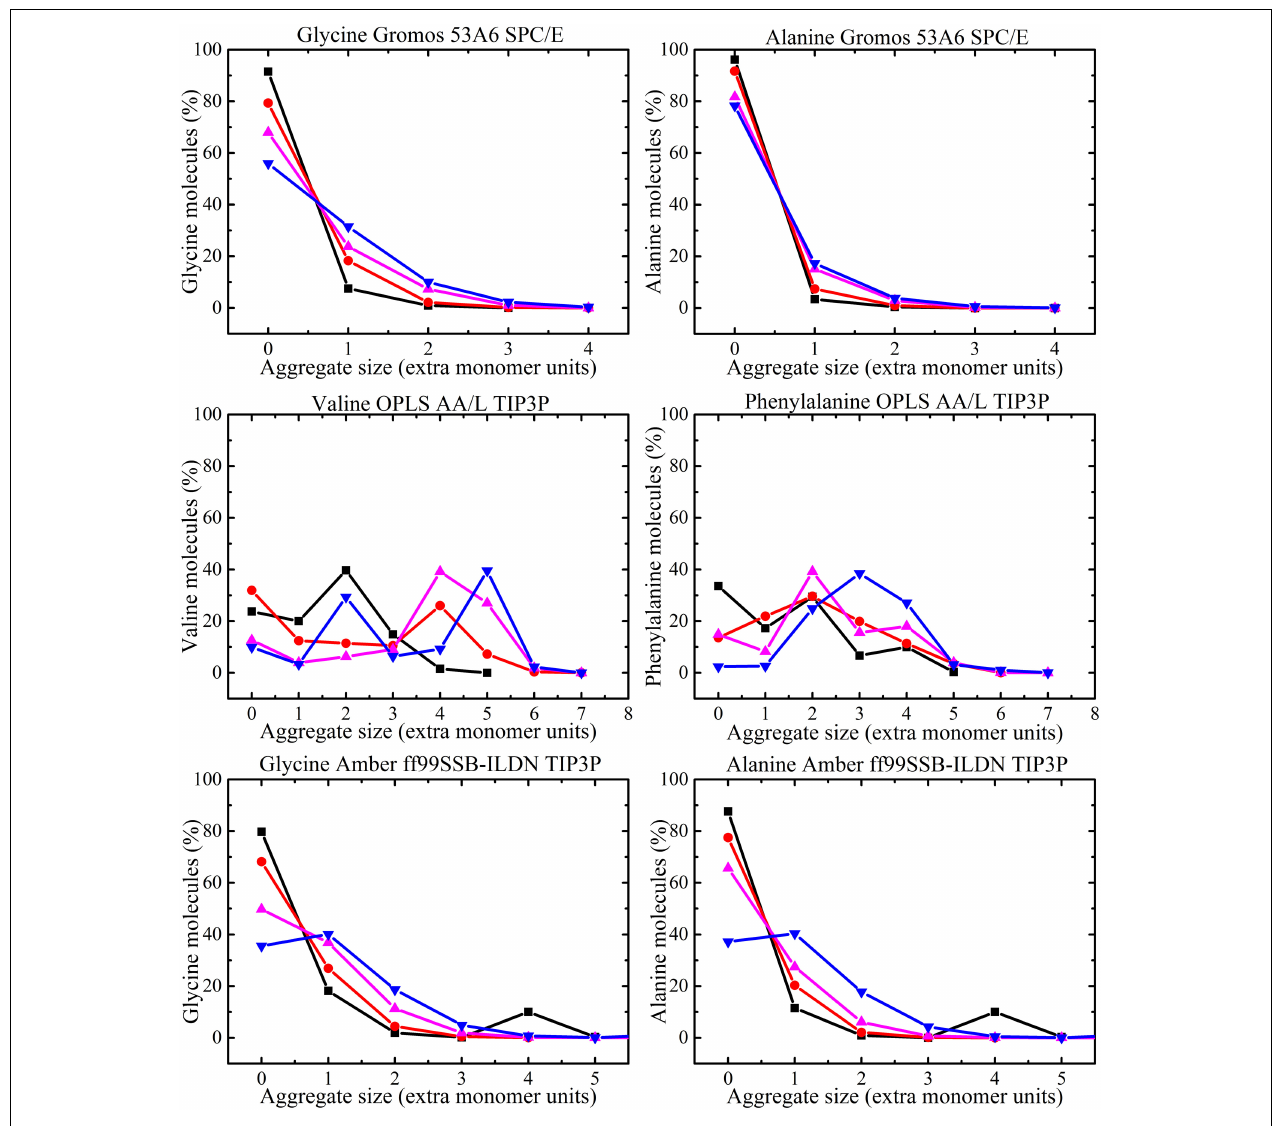
FIGURE 10 | Aggregate size distribution for each amino acid as a function of concentration [i.e., 50 ( ), 100 ( ), 200 ( ), and 300mg/ml ( )] determined using different force fields at 298 K.